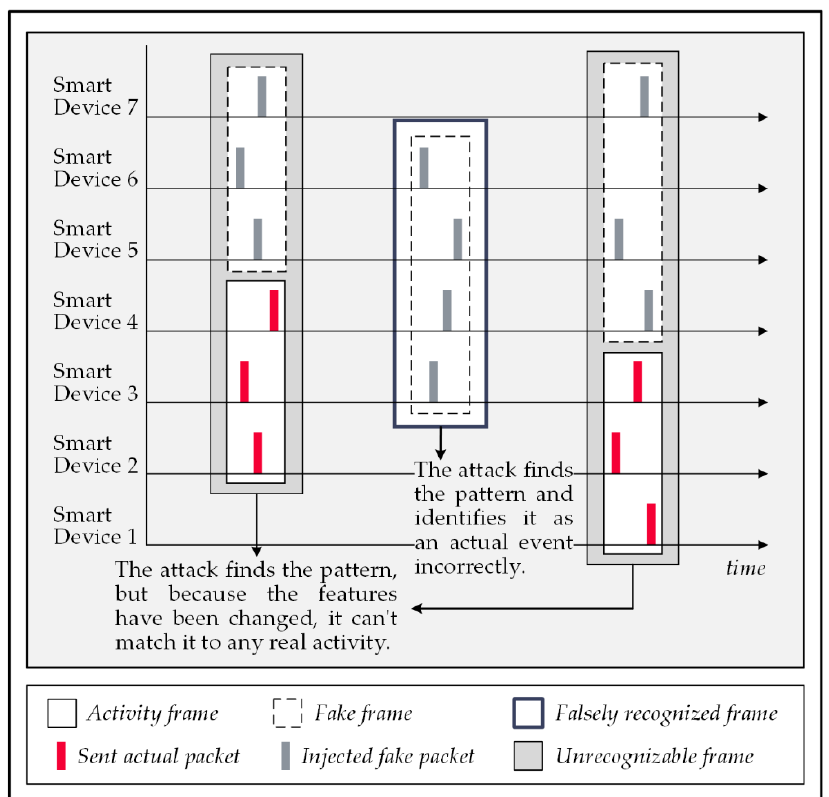
Figure 14. Actual activity mimicking method.